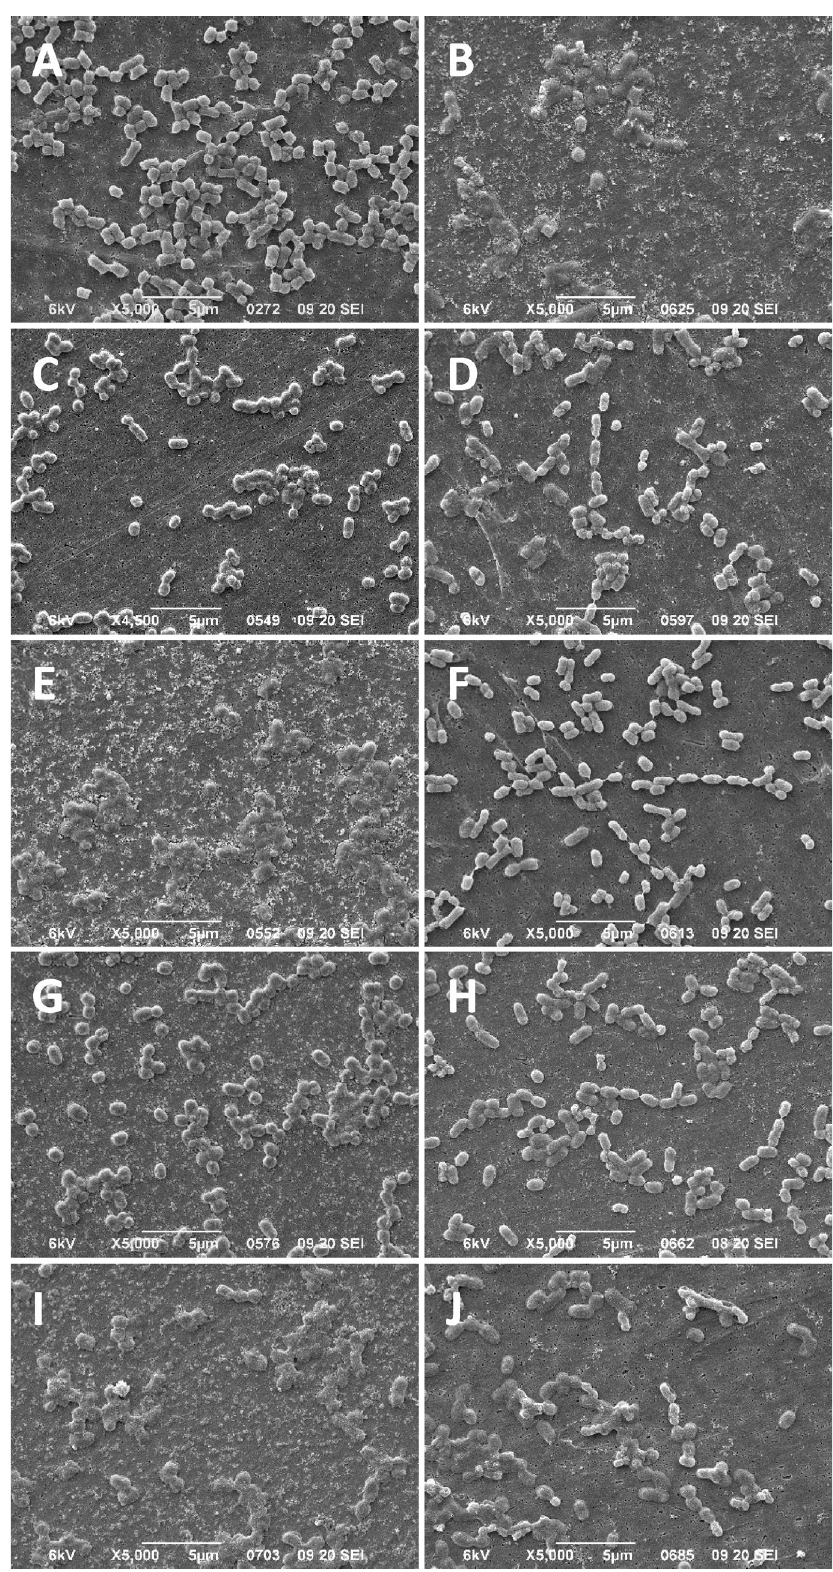
Figure 4. SEM images of EC and ECCETT exposed to increasing concentrations of CET for 30-min. ( A , C , E , G , I ) show EC isolates and ( B , D , F , H , J ) show ECCETT isolates after 30-min exposure to CET at 0 µg/mL ( A , B ), 18.8 µg/mL ( C , D ), 37.5 µg/mL ( E , F ), 75 µg/mL (G, H) and 300 µg/mL ( I , J ). All images are representative of 5 SEM images collected at 5000× magnifications and the white scale bar at the bottom of each panel image indicates 5 µm